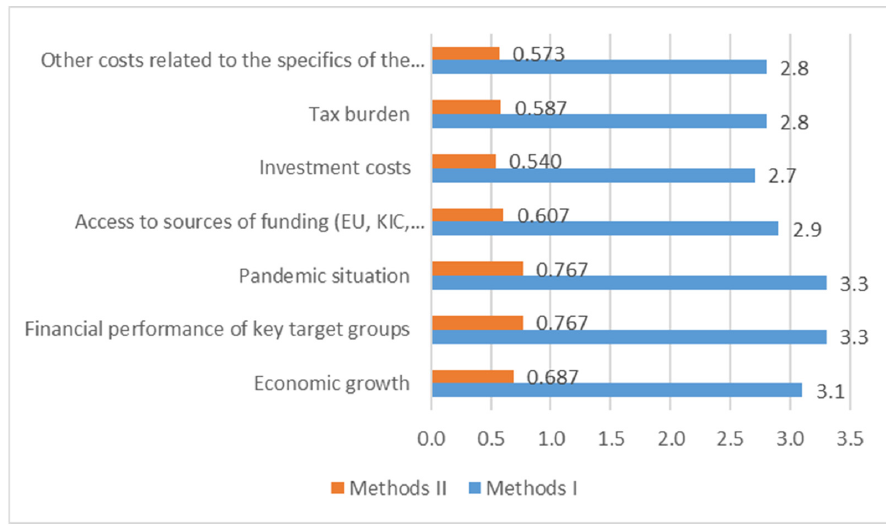
Figure 8. Summary of the results for economic factors with both methods. Authors’ own study.